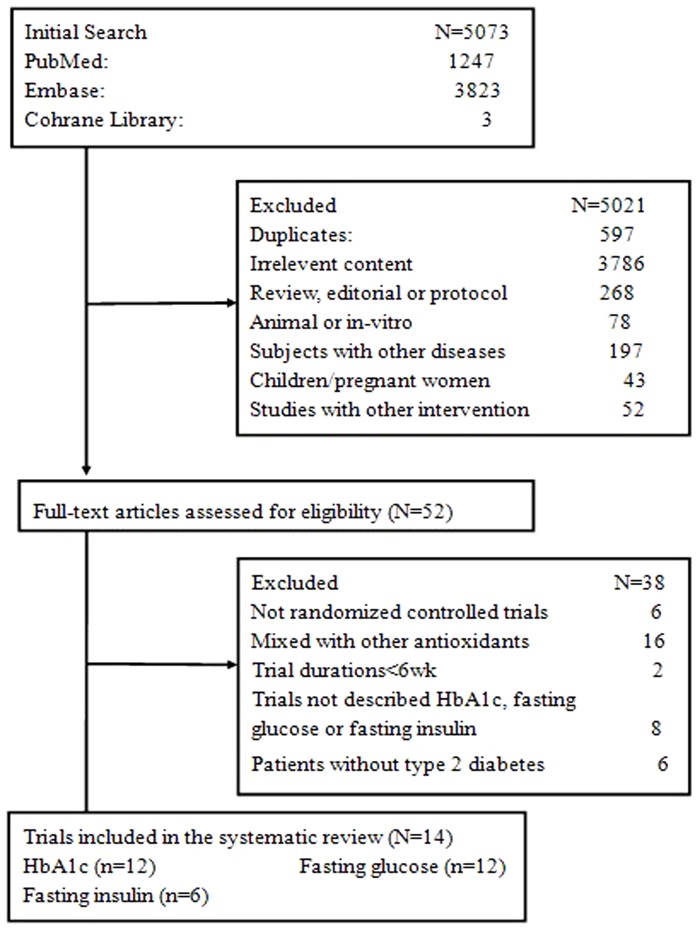
Flow diagram of the process of article selection for meta-analysis.